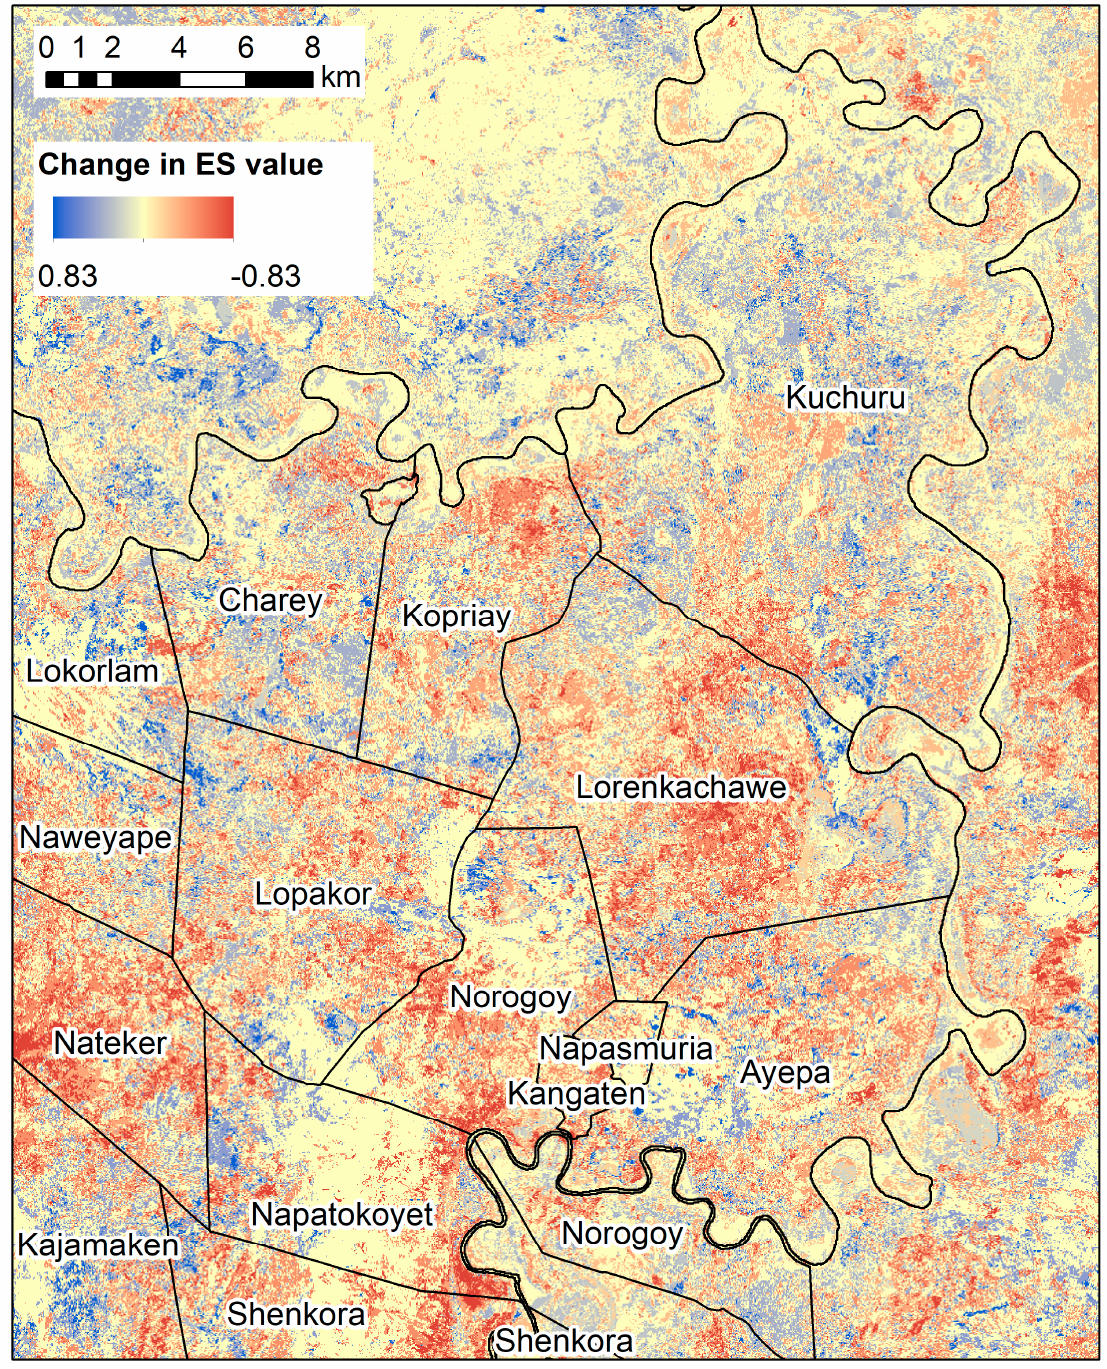
Figure 7. Map of change in provisioning Ecosystem Service (ES) value (metrics derived from participatory mapping) between the periods 2000–2003 and 2016–2019 for kebeles in Nyangatom, South Omo Zone, Ethiopia. The right-hand panel of Figure 6 was recreated for 2000–2003, and this figure shows the change over time for ES value.